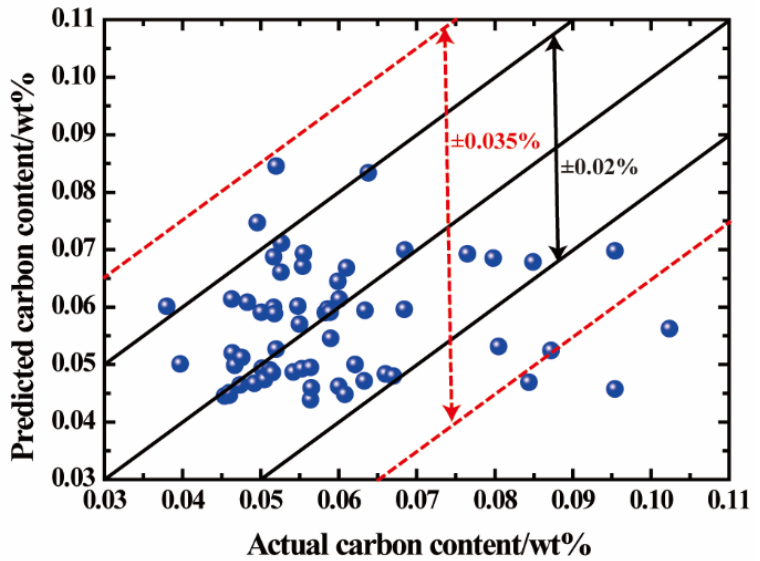
Figure 7. The prediction results of carbon content at the steelmaking end-point.